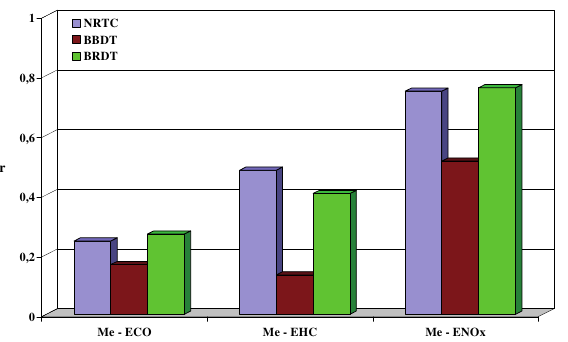
Fig. 16. The coefficient of Pearson’s linear correlation – r between engine torque and pollutant emission intensity in individual tests